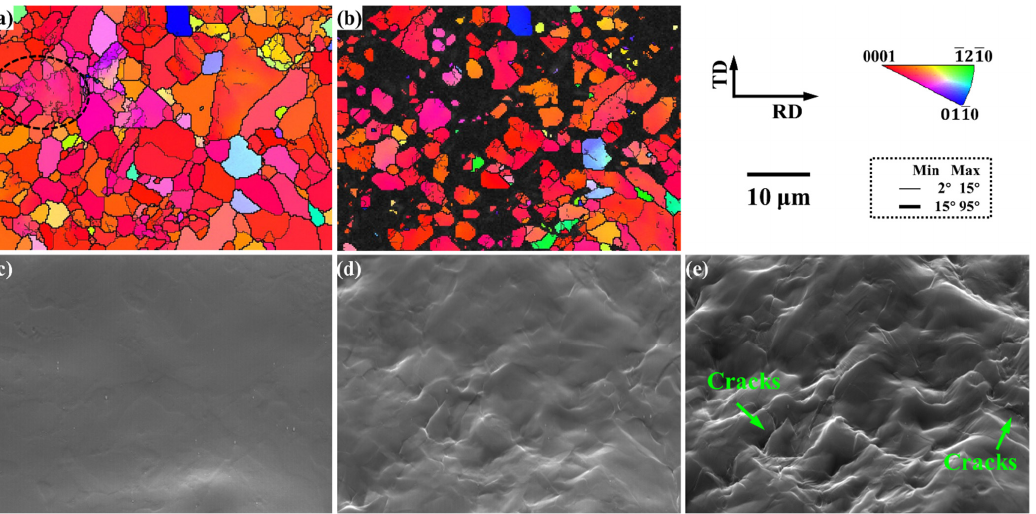
Figure 5. Microstructure evolution of the quasi-in situ tensile test of the as-rolled microstructure of magnesium alloys at different strain stages: ( a , c ) Original stage: S0, ( b , d ) yield stage: S1, ( e ) fracture stage: S2.